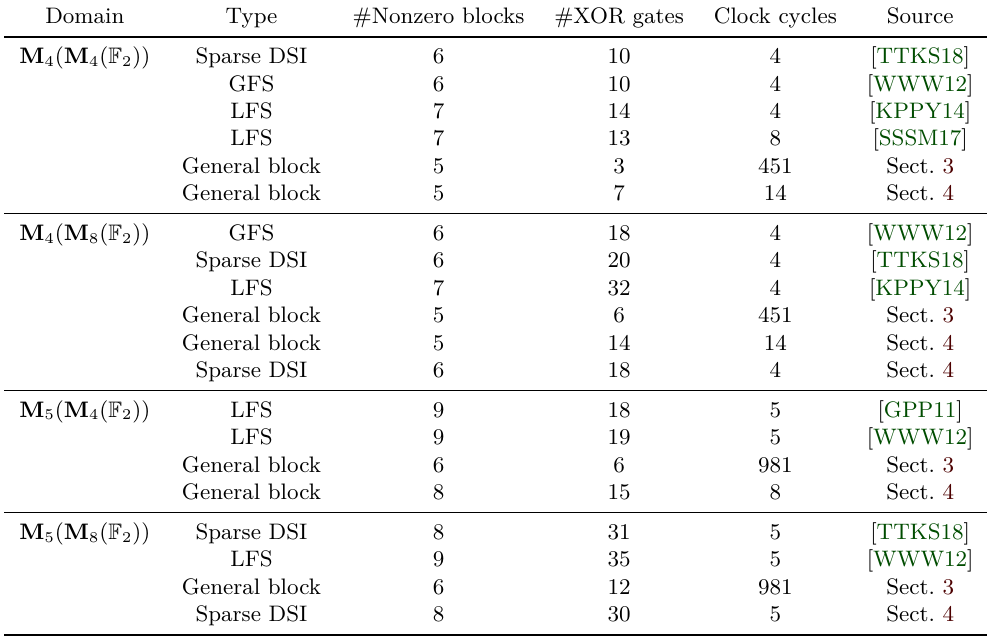
Table 1: A comparison with previous results, where all costs are recalculated with Boyar’s SLP heuristic [BMP13]